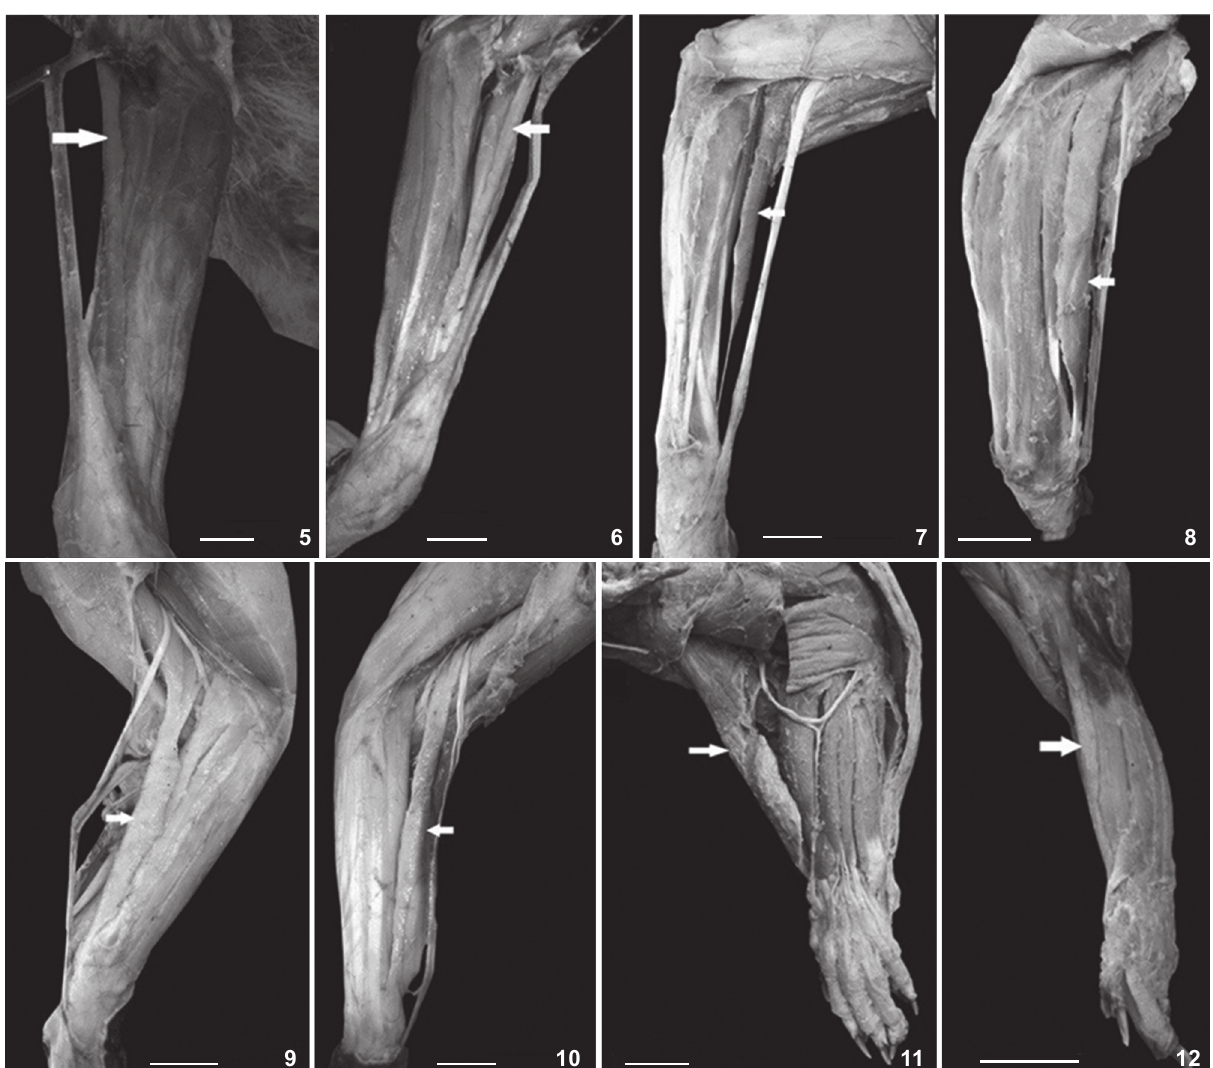
Figures 5-12. Photomacrographs showing the comparative anatomic arrangement of the brachioradialis muscle (white arrow) in the forearm region of: (5) Cerdocyon thous , right forearm; (6) Lycalopex gymnocercus , left forearm; (7) Procyon cancrivorus , right forearm; (8) Nasua nasua , right of forearm; (9) Leopardus geoffroyi , left forearm; (10) Leopardus colocolo , right forearm; (11) Lontra longicaudis , left forearm; (12) Galictis cuja , left forearm. Scale bars: 20